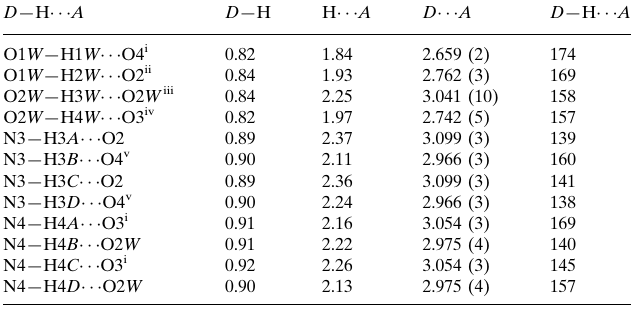
Hydrogen-bond geometry (A˚ , (cid:2)